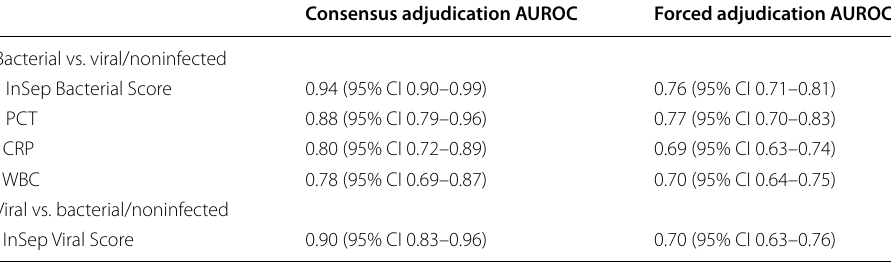
Table 2 Comparison of AUROCs applying consensus vs. forced adjudications for InSep and other commonly used